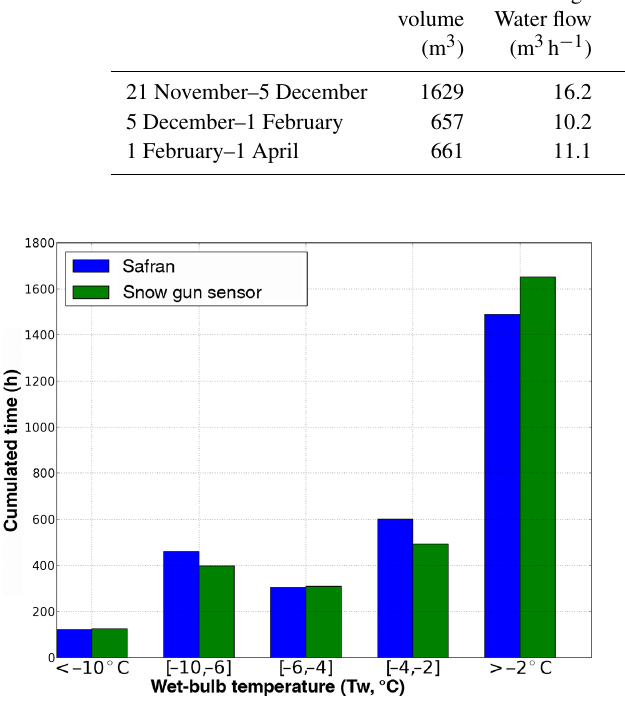
Table 7. Observed production conditions for the main periods of production before and after the resort opened. Period